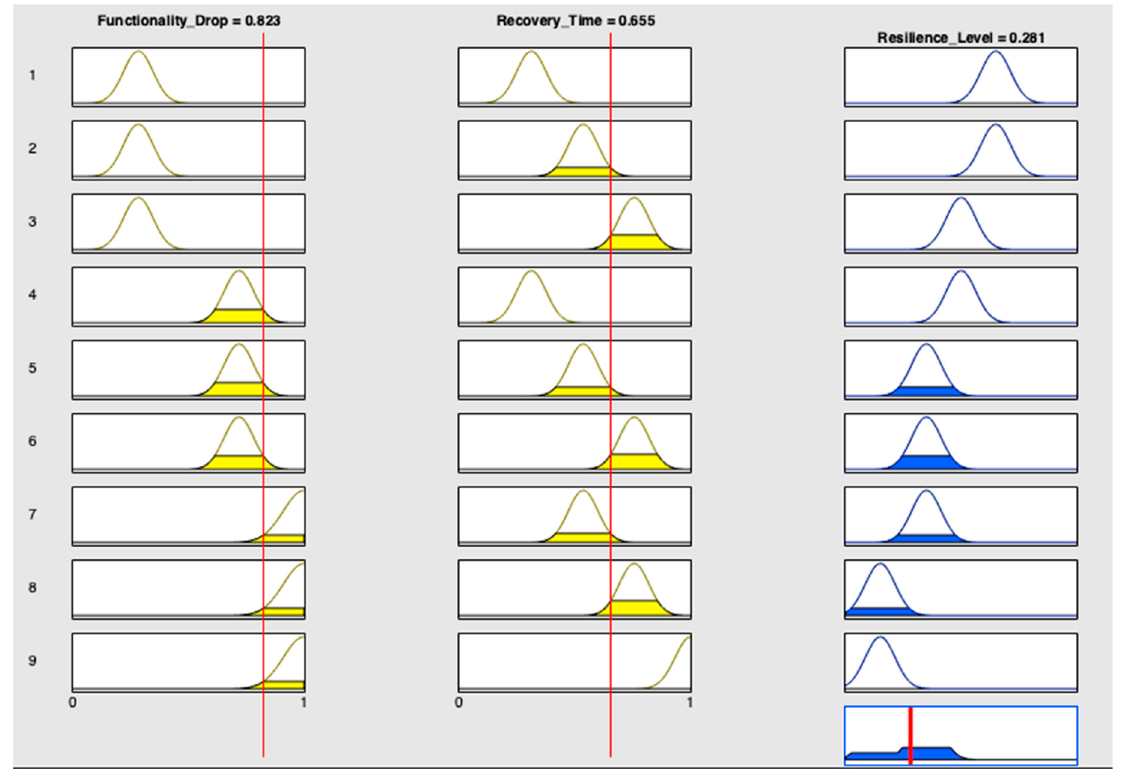
Figure 4. Representation of the set of fuzzy rules and the defuzzificated value of the